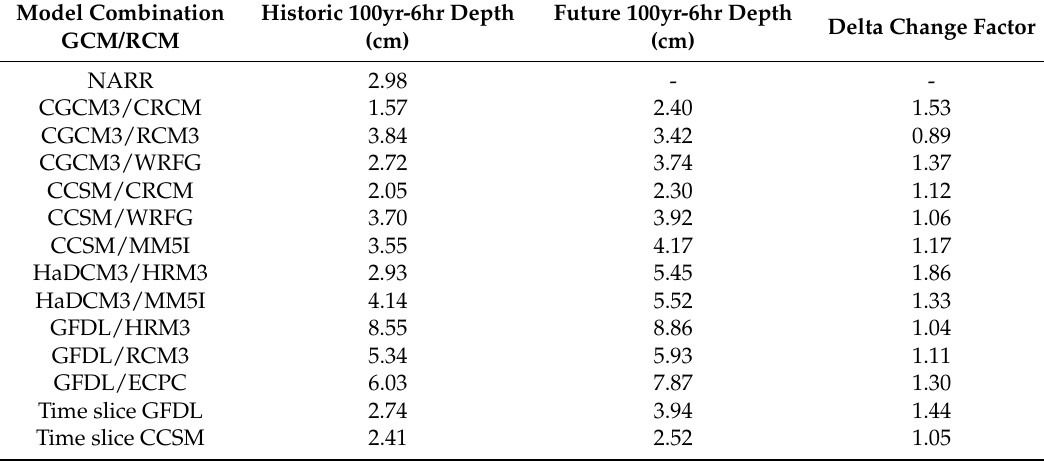
Table 2. Historic and projected 100yr-6hr depths and delta change factors from North American Regional Climate Change Assessment Program (NARCCAP) and North American Regional Reanalysis (NARR) climate